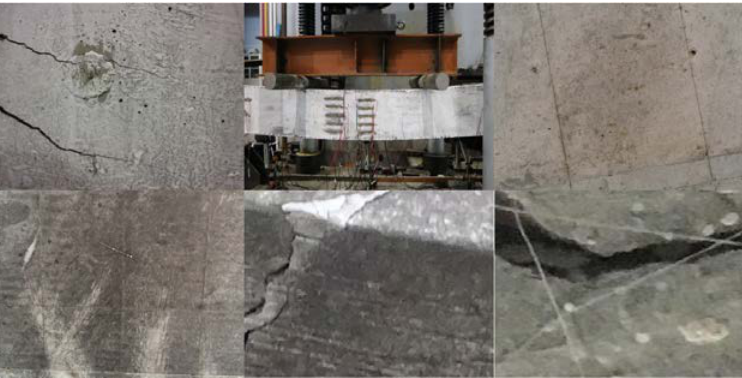
Figure 4. Examples of the dataset.